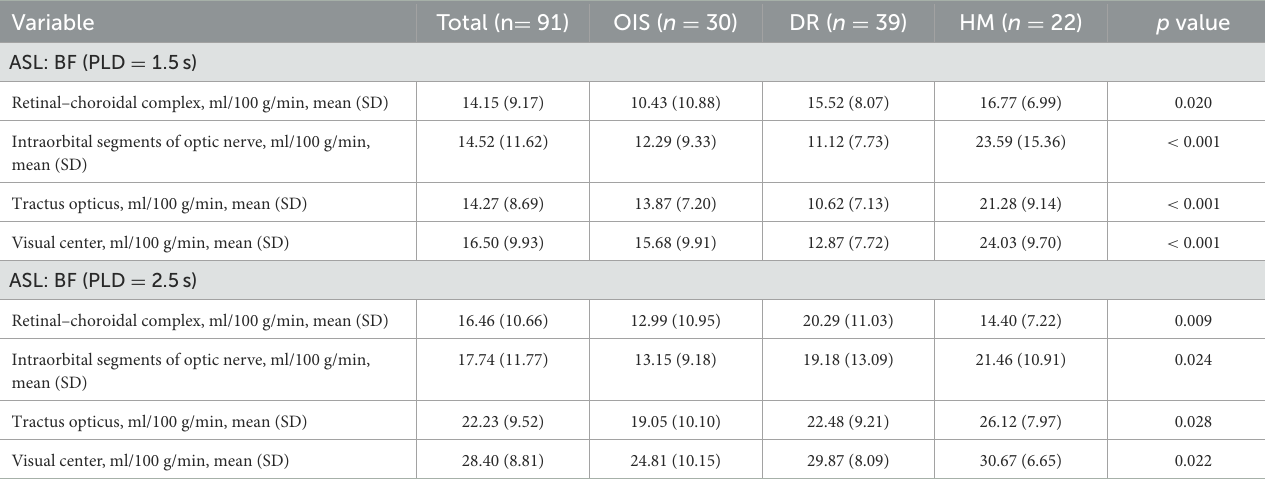
TABLE 2 ASL characteristics based on ROI